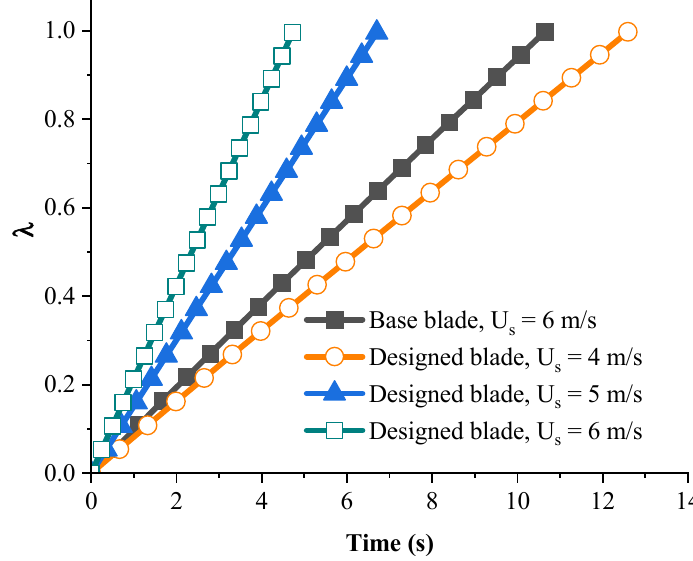
Figure 21. Changes of λ during the startup process for the designed and base blades.